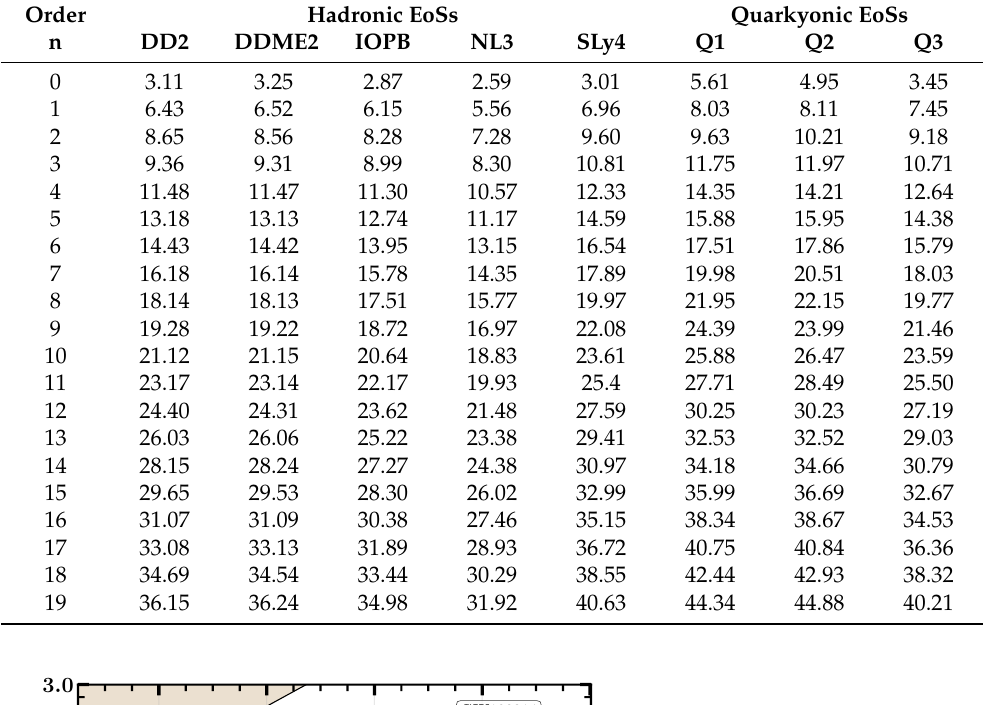
Table 1. Frequencies f n (in kHz) of the 20 lowest radial oscillation modes for our choice of five hadronic and three quarkyonic unified EoSs taken at 1.4 M (cid:12) . Order Hadronic EoSs Quarkyonic EoSs n